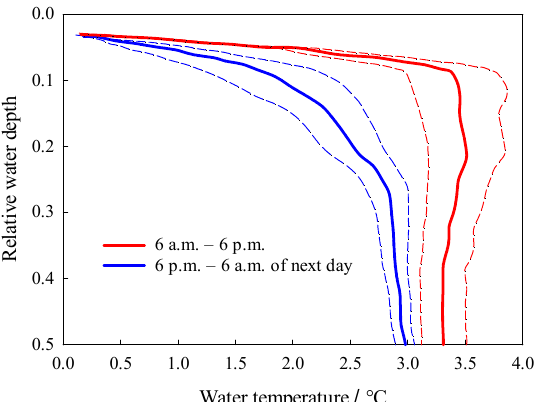
Figure 7. Diurnal variations in the vertical profiles of water temperature during the late winter.